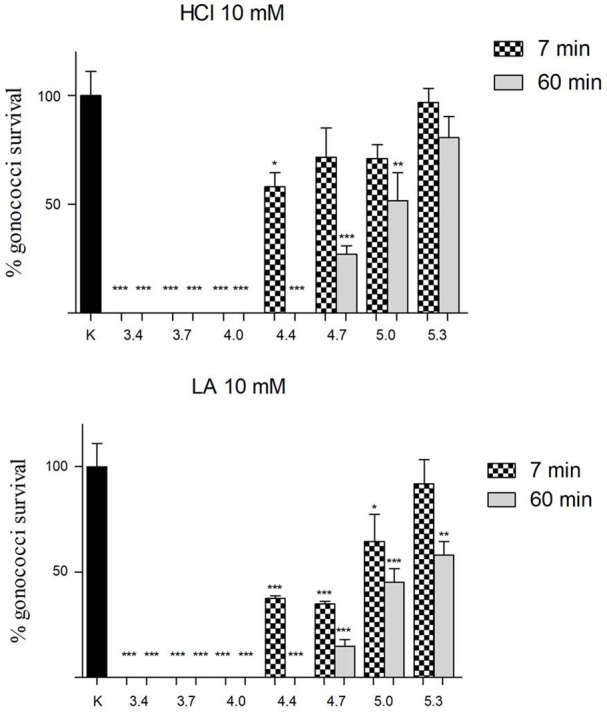
Effect of lactic and hydrochloric acid on GC viability. Solutions of hydrochloric acid (HCl) and lactic acid (LA) at a concentration of 10 mM, buffered to different pH values (3.4, 3.7, 4.0, 4.4, 4.7, 5.0, 5.3), were used for “inhibition” experiments against GC at two different time points (7 and 60 min; dotted and gray bars, respectively). GC viability was evaluated as number of gonococci/mL and expressed as % of gonococci survival. The results were expressed in percentage compared with control (K) (1 × 108 gonococcal cells incubated in 150 mM NaCl solution, pH 5.8), taken as 100% (black bar). Bars represent mean values, whereas error bars represent SEM. Statistical significance was determined at *P < 0.05, **P < 0.01, and ***P < 0.0001.